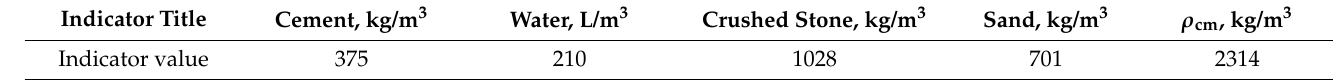
Table 3. Parameters of the composition of the concrete